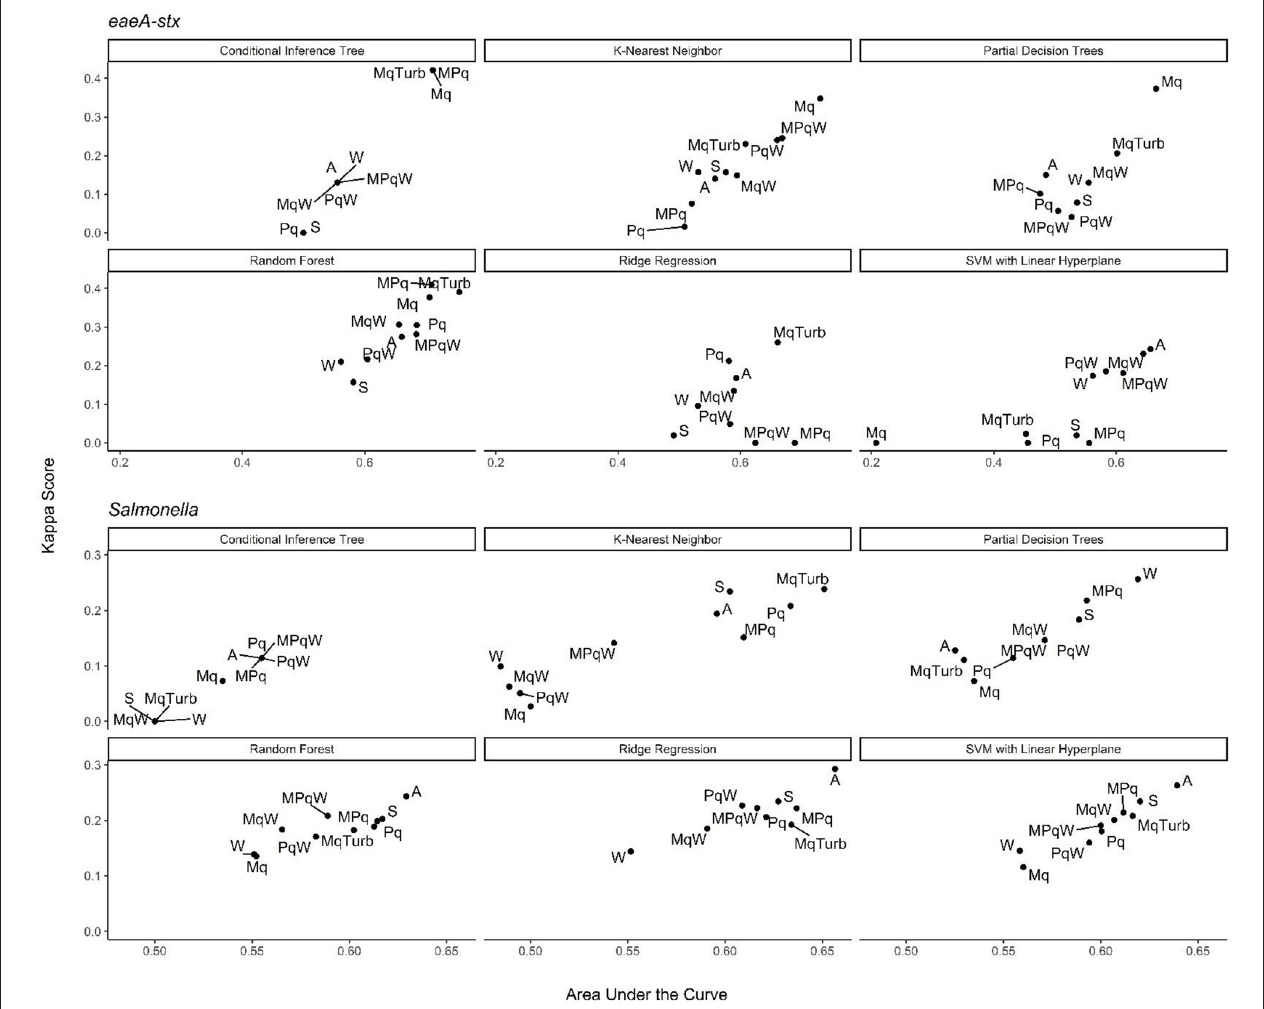
FIGURE 6 | Kappa score and AUC for the nested models. Results are faceted by model outcome and learner: Mq, microbial; MqTurb, microbial data and turbidity; Pq, Physicochemical water quality and air temperature collected on site; W, Weather from publicly-available databases; S, Spatial. With the exception of the Mq models, each nested model used data on site traits (e.g., stream bottom substrate). Top performing models are in the top right corner of each facet.